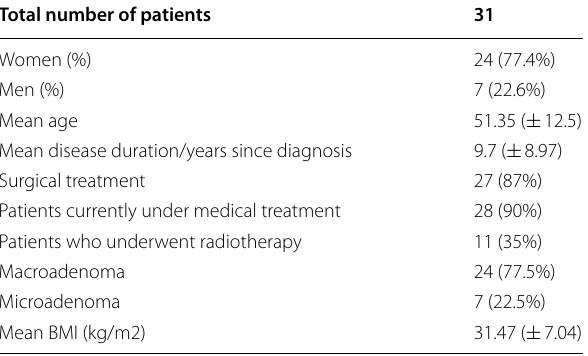
BMI Body mass index. For the variables expressed as means we expressed the standard deviations in parentheses